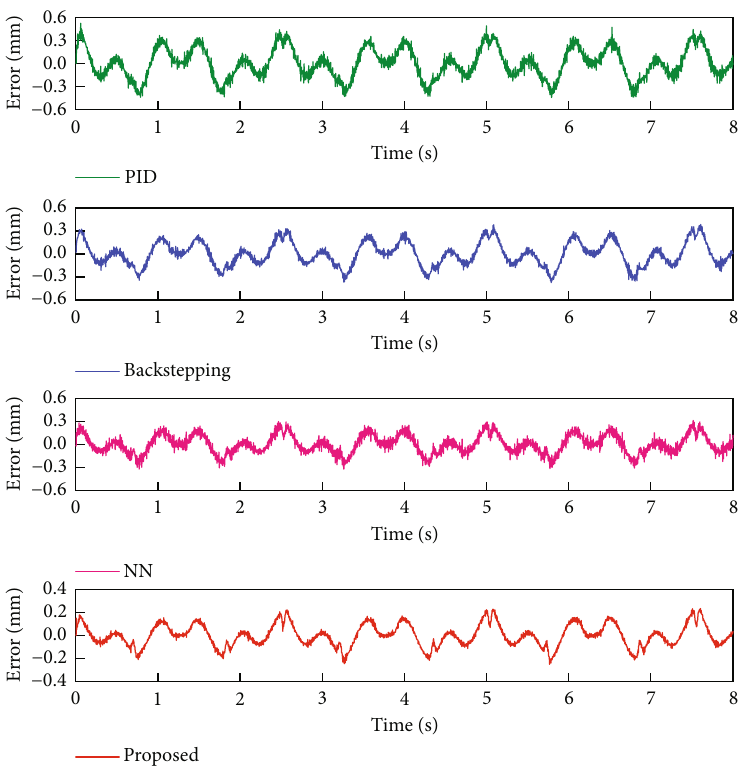
Figure 5: Tracking error of multifrequency sine signal. Table 1: Performance indicators for multifrequency sine